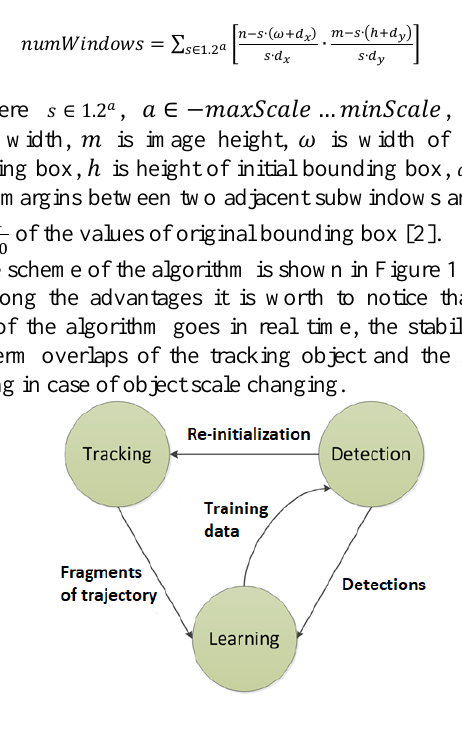
Figure 1 . Scheme of the algorithm